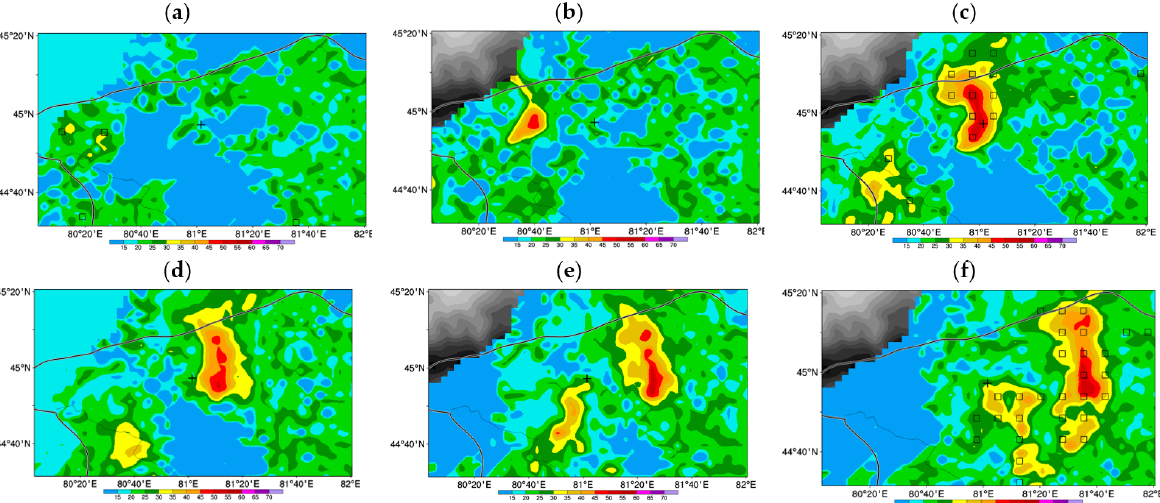
Figure 6. Observed composite reflectivity fields (unit dBZ) at ( a ) 0700 UTC, ( b ) 0730 UTC, ( c ) 0800 UTC, ( d ) 0820 UTC, ( e ) 0840 UTC, and ( f ) 0900 UTC 30 July 2019. The black squares indicate the reflectivity assimilated, in which observed radar reflectivity is higher than 25 dBZ which is same below. The shades of gray indicate the model terrain height in each plot which is same below. During each successive data assimilation cycle, the horizontal and vertical cross-sec- tions of assimilated reflectivity for C2Rad (Figure 7a–c), C1Con and C3RadBy omitted show little difference between each other at 0800 UTC because very few radar observa- tions assimilated at 0600 UTC and at 0700 UTC in which most of radar reflectivity lower than 25 dBZ. The observed and assimilated reflectivity fields have large differences at 0800 UTC in horizontal space which are displaced by about 10–30 km from each other. There are multiple thunderstorms forecasts at the western and north-eastern of Wenquan station (Figure 7a,b) which accompanied with strong ascending and descending movements (Fig- ure 7c,d).